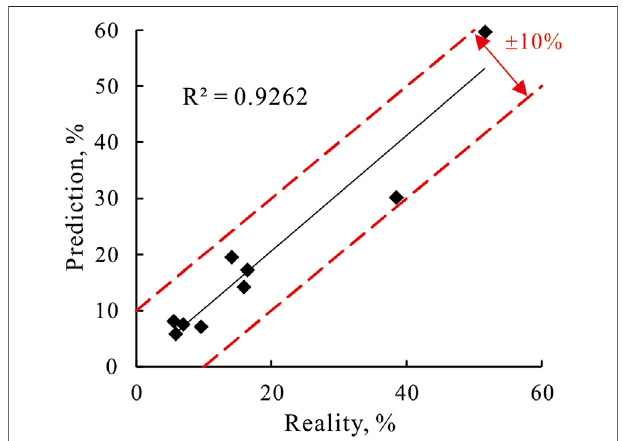
FIGURE 4 | Prediction model